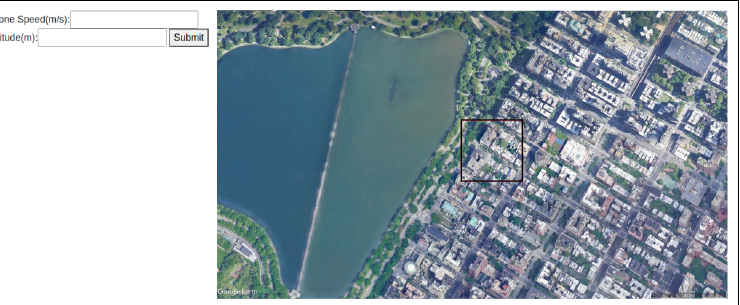
Figure 3. Example of the simulator screen. The drone speed and altitude values are inserted on the left and submitted by the user (by clicking on the “Submit” button); the user clicks on the image and uses the arrows to move the black frame on the map; to finish, the user presses